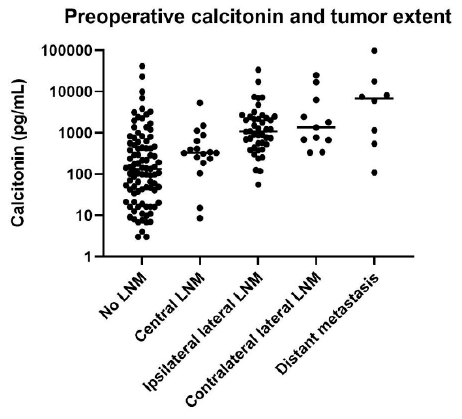
Figure 2. Correlation between tumor extent and preoperative serum calcitonin levels. The dots represent serum calcitonin level in each patient, and the horizontal lines represent the mean of the group. Table 4. Lymph node metastasis and distant metastasis by preoperative serum calcitonin levels. Calcitonin